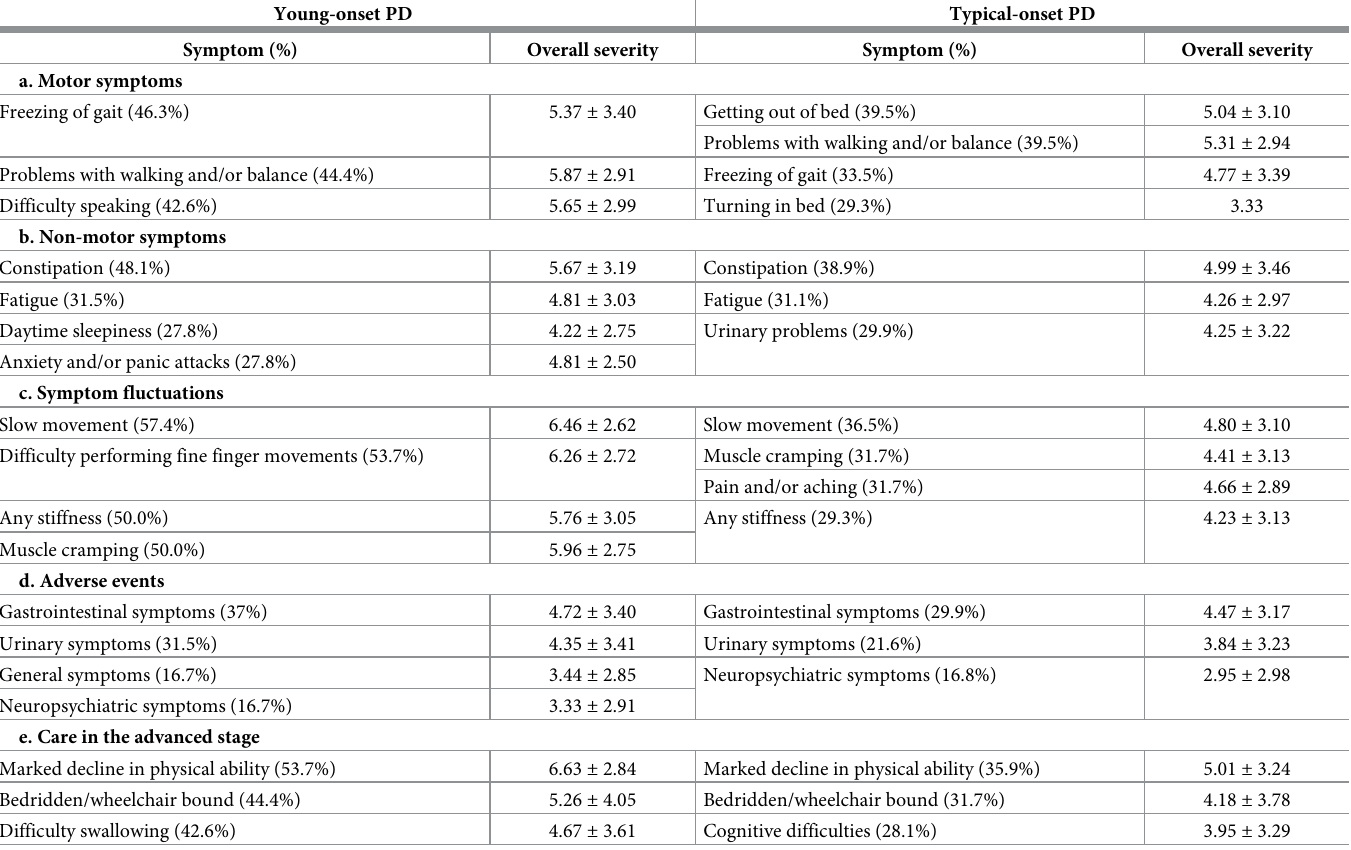
Table 5. Comparison of the most commonly concerning symptoms between young-onset and typical-onset PD patients on (a) motor symptoms, (b) non-motor symptoms, (c) symptom fluctuations, (d) adverse events, and (e) care in the advanced stage (n = 222)